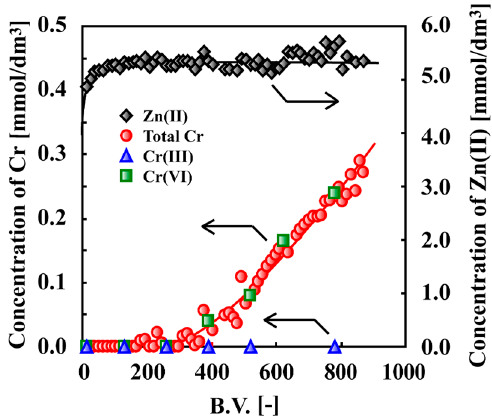
Figure 40. Zn(II) and Cr species breakthrough profiles for a column packed with crosslinked persimmon gel at pH = 4 using the same conditions given for Figure 39 [35]. (With permission for reuse from Elsevier B.V.).